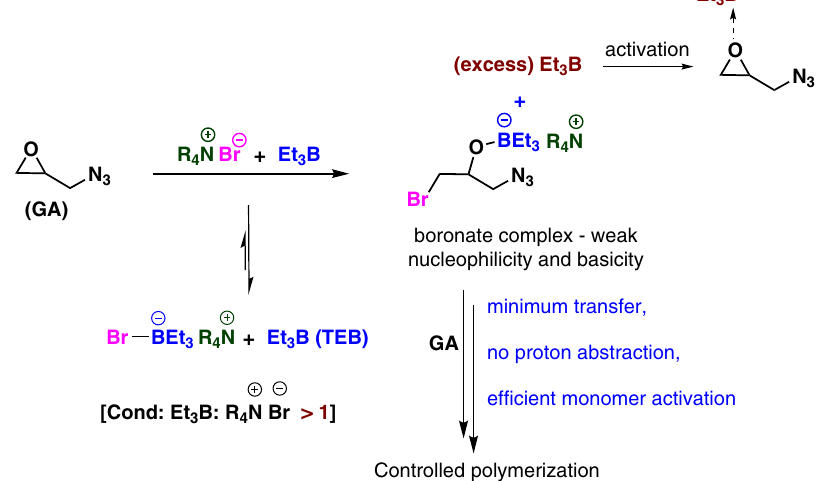
Fig. 1 Role of excess of TEB in GA Polymerization. An excess of TEB is required for the GA polymerization to occur. Firstly, an ate complex is formed upon mixing stoichiometrically TEB with the initiating anion; such ate-complexes exhibit a weak nucleophilicity and basicity which prevents the occurrence of undesired transfer reactions and proton abstraction from the monomer. Secondly, the excess of TEB serves to activate the